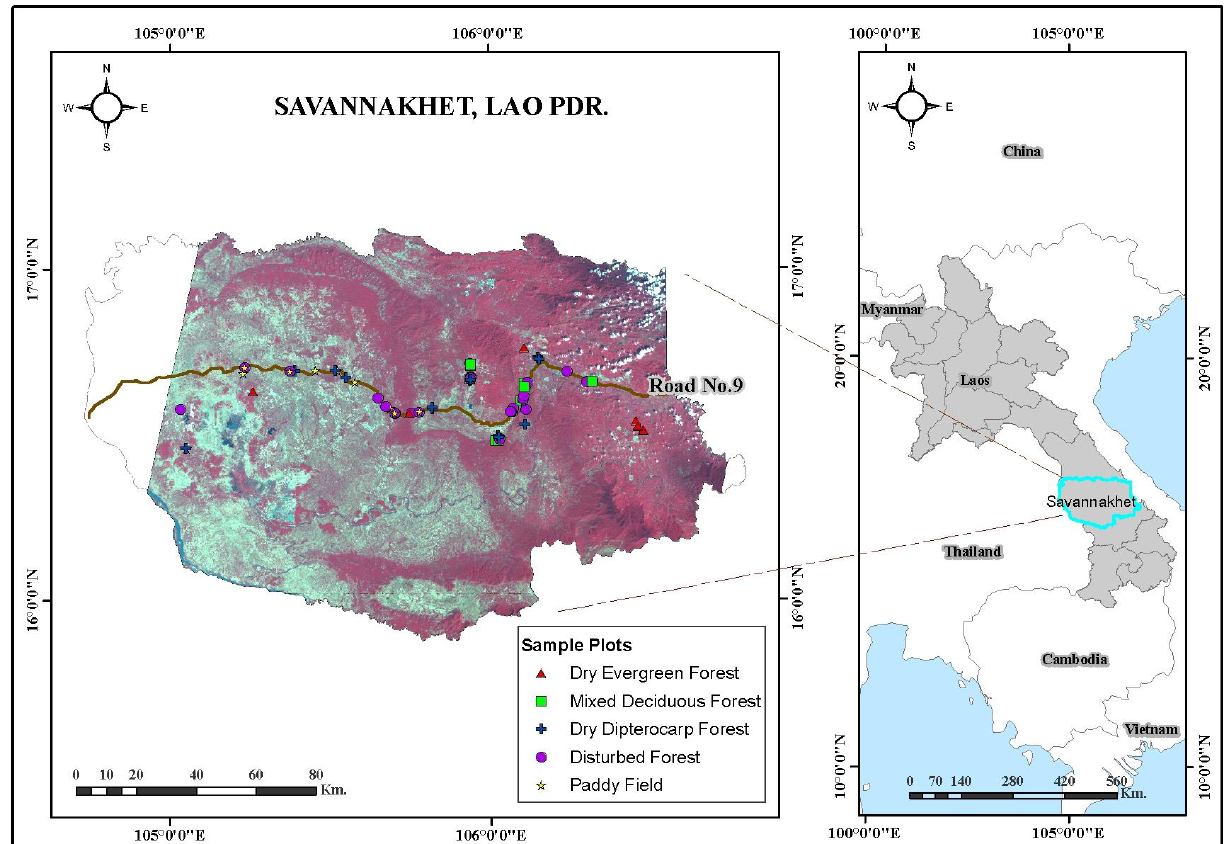
Figure 1. The location of the study area inventory plots in Savannakhet Province, Lao